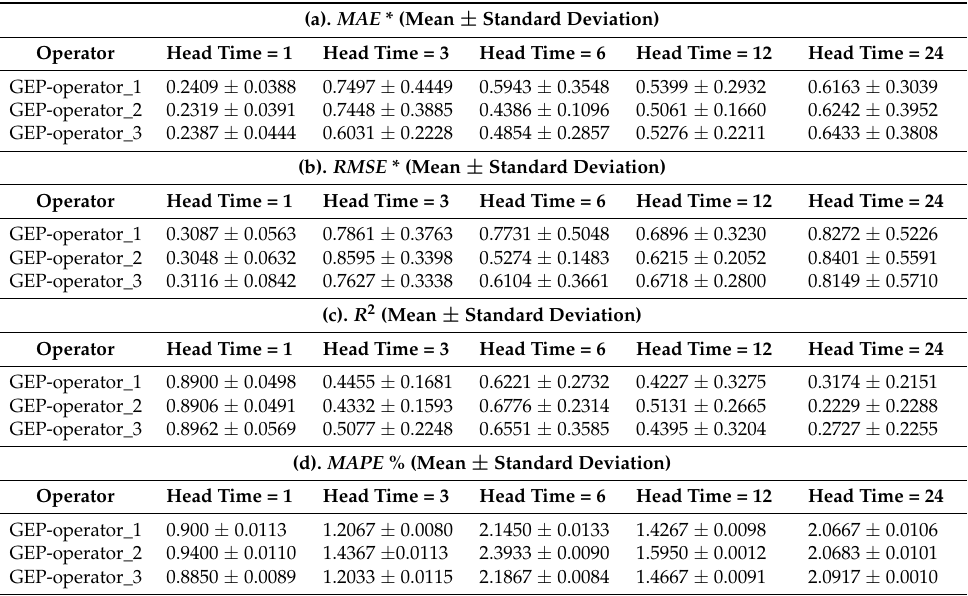
Table 1. Performance indices averaged clusters: ( a ) MAE , ( b ) RMSE , ( c ) R 2 , and (d) MAPE